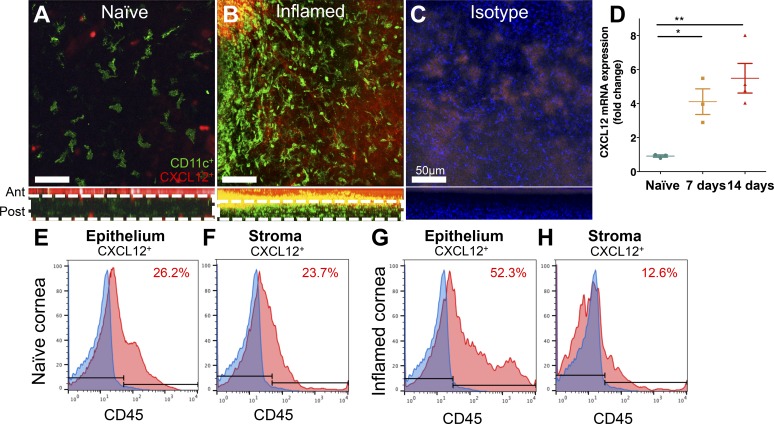
CXCL12 expression in the naïve and inflamed cornea. Representative confocal micrograph of naïve (A) and inflamed (B) BALB/c corneas, with the respective isotype control (C), show expression of CD11c+ cDCs (green) and CXCL12 (red) within the corneal stroma. The orthogonal views reveal CXCL12 intensity from the naïve and inflamed corneal epithelium. Further, the white dotted box denoted within corresponding orthogonal views below each en face image highlights the area presented in the top panel images. CXCL12 mRNA expression is upregulated in the cornea 7 and 14 days after suture placement compared with naïve corneas (D). Representative histograms of flow cytometric analysis of CXCL12 expression within CD45+ leukocytes in the naïve (E) and inflamed (F) corneal epithelium and stromal layers. Scale bars denote 50 μm. Data are shown as mean ± SEM. *P < 0.05, **P < 0.01. n = 3/setting.